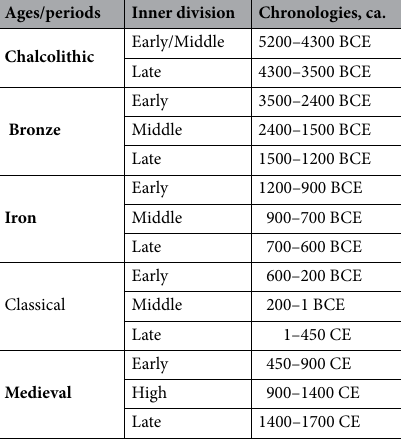
Table 1. Relevant periods and dates associated with the occupations of the Aren-1 cave complex. Periods with occupations at the Areni-1cave are given in bold.